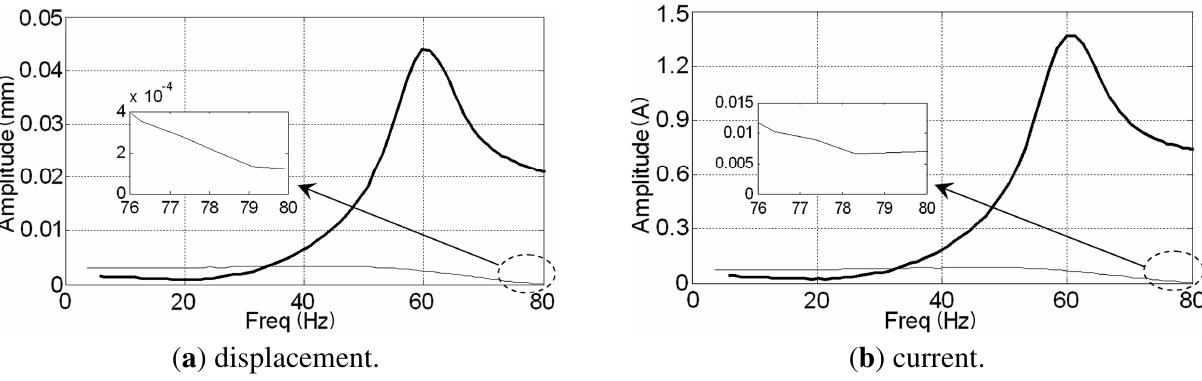
Figure 21. Amplitude of synchronous displacement and current of AX-channel from 80 Hz to 0 before (bold curve) and after (thin curve) balancing at 80